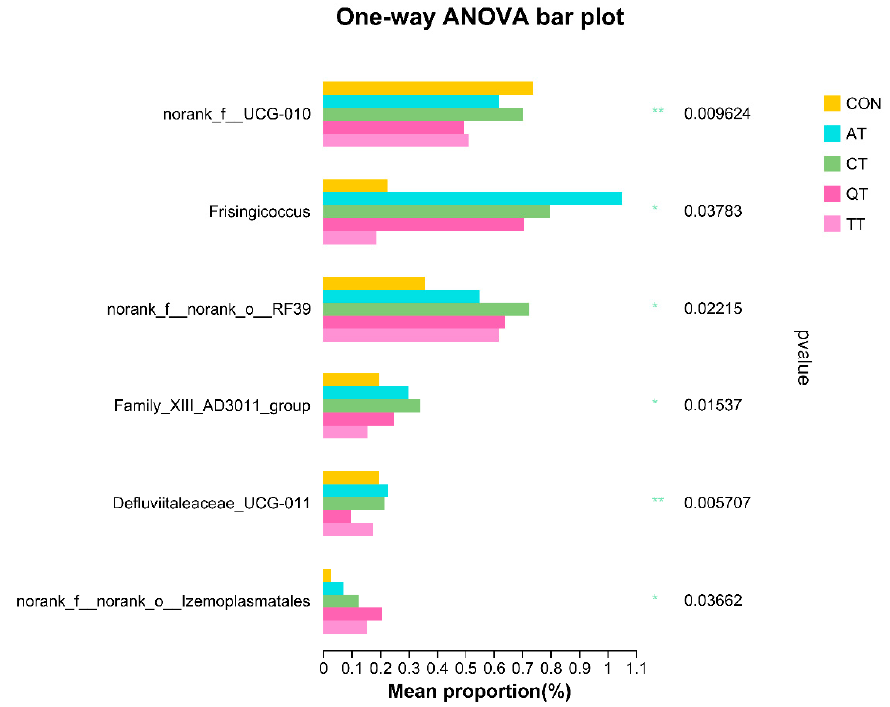
Figure 8. Heatmap showing Spearson correlation analysis between antioxidant-related and immune-related indicators with bacterial genera, p < 0.05. The red blocks represent positive correlations, and the blue blocks represent negative correlations. The colors’ shades indicate the strength of the correlations. * p < 0.05, ** p < 0.01, and *** p < 0.001 compared with CON group.